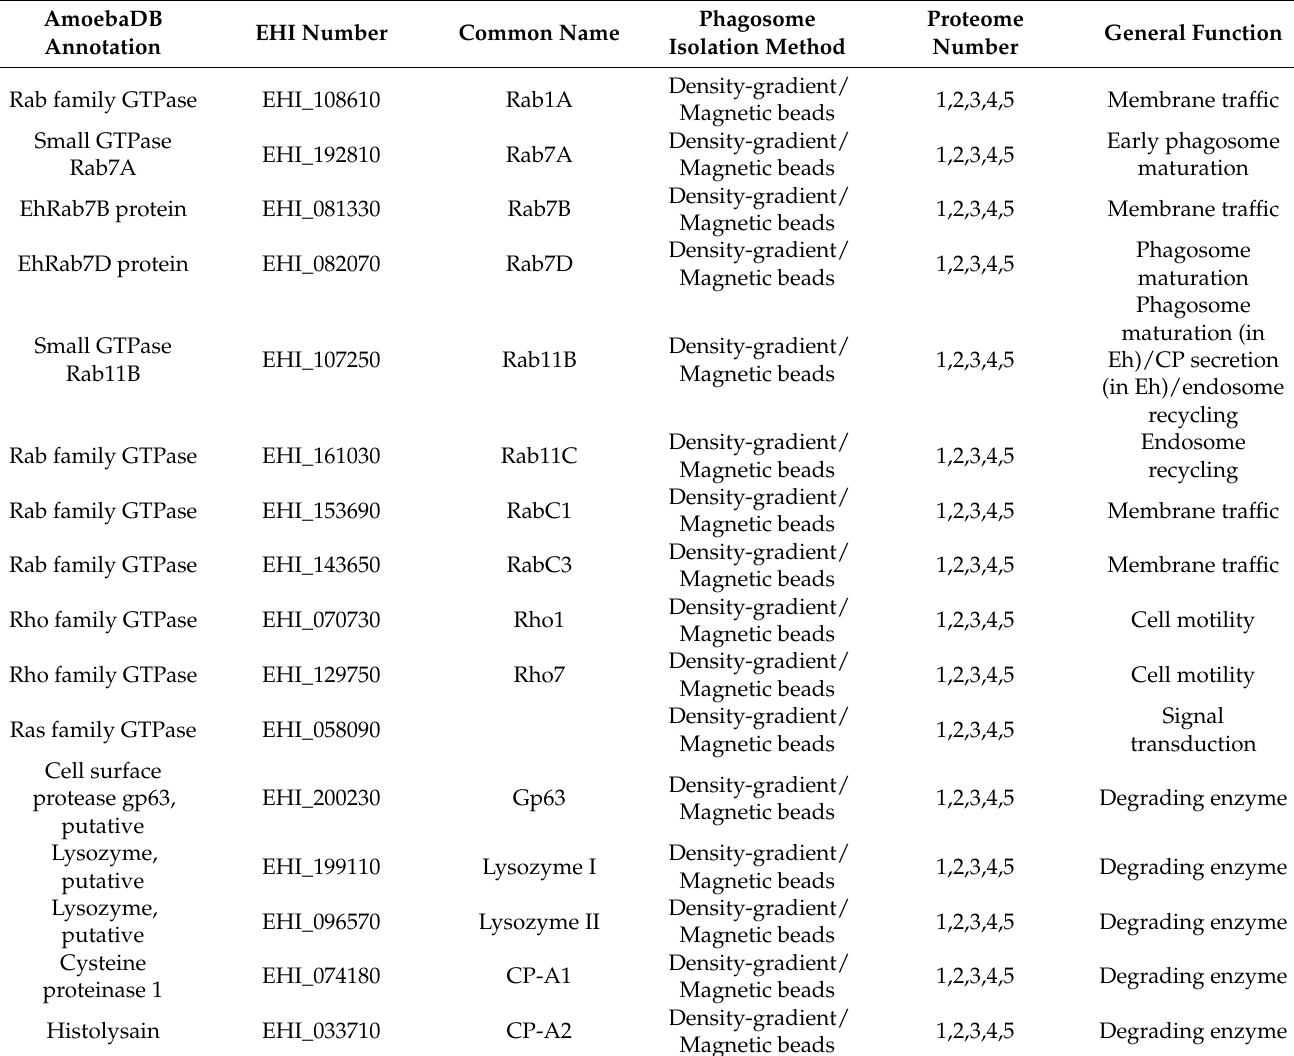
Table 2. Small G-proteins and degrading enzymes detected in all proteomes, and Small G-proteins detected in Proteomes 4 and 5 and categorized into “protein-binding activity